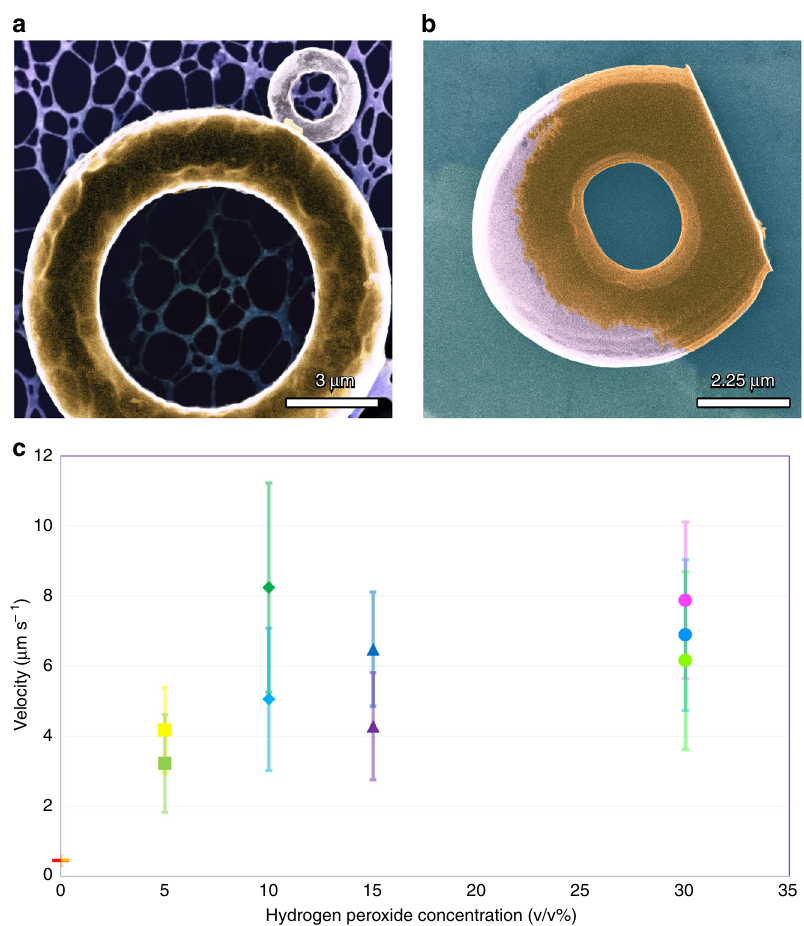
Fig. 1 Tori with two types of surface coating. a A High-resolution transmission electron microscope (STEM) image of “ glazed ” Janus torus on a carbon lacey TEM grid. The metallic cap has been applied to the top of the tori. The scale bar is 3 μ m. b SEM image of a “ dipped ” Janus tori on a carbon TEM grid. The bottom of the torus is “ cut off ” at the bottom to provide a stable base during printing and the metal evporation. The scale bar is 2.25 μ m. c A graph representing the propulsion velocity dependence on the concentration of hydrogen peroxide. Red and orange horizontal bars are respectively the propulsion velocities glazed and dipped tori (with 40 nm Ni and 10 nm Pt) on a gold substrate at 0% H 2 0 2 . Green and yellow squares are respectively the propulsion velocities glazed and dipped tori (with 40 nm Ni and 10 nm Pt) on a gold substrate at 5% H 2 0 2 . Dark green diamond is the propusion velocity of glazed tori (with 40 nm Ni and 10 nm Pt)on a glass substrate at at 10% H 2 0 2 ; and comparitively,teal diamond is the propulsion velocity of dipped tori (with 40 nm Ni and 10 nm Pt) on a gold substrate at 10% H 2 0 2 . Purple and dark blue triangles are, respectively, the propulsion velocities glazed (with 40 nm Ni and 10 nm Pt) and dipped tori (with 10 nm Ni and 40 nm Pt) on a gold substrate at 15% H 2 0 2 . Magenta, lime, and ice blue circles are the propulsion velocity of 3 μ m diamater glazed tori, 7 μ m glazed tori, and 7 μ m dipped tori at 30% H 2 0 2 . The three tori have a coating of 40 nm Ni and 10 nm Pt. A full legend can be found in Supplementary Fig. 3 and in Supplementary Note 2. The error bars represent a unique standard deviation for that particular Fig. 3c. By contrast, in glazed tori with a thin nickel layer (10 nm),